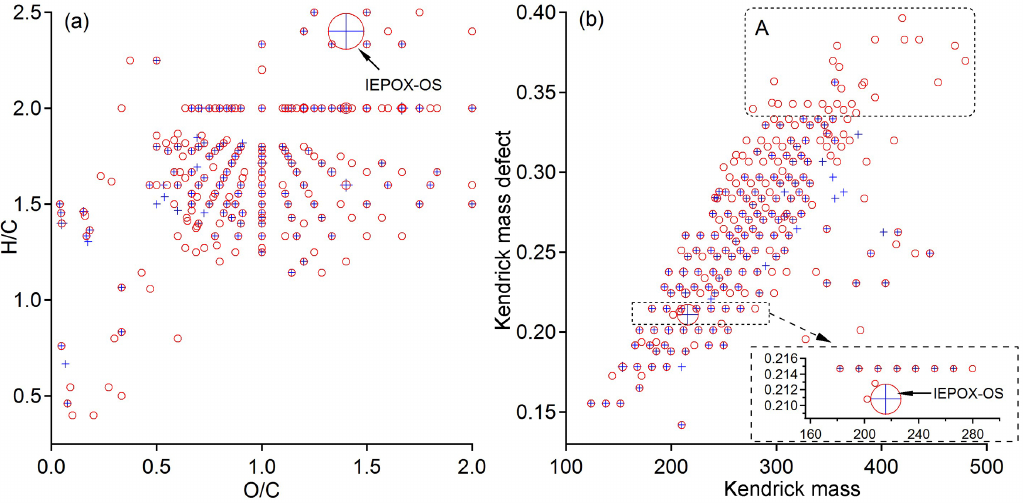
Figure 8. Overlaid Van Krevelen diagram (a) and Kendrick mass defect plot (b) for CHOS-containing formulae in the samples from the periods with low (blue markers) and very high incidents of fires (red markers). The marker areas reflect relative ion abundance in the sample. Red markers correspond to the ions from the period with the lowest incidents of fires. Note that IEPOX-OS is not a part of any homologous series in the sample with very low incident of fires and it has only one additional homologue in the sample that experienced very high incident of fires (see enlarged area of Fig. 8a). Area “A” in Kendrick mass defect plot shows formulae with KMD > 0.33 that are mainly present in the sample with high incident of